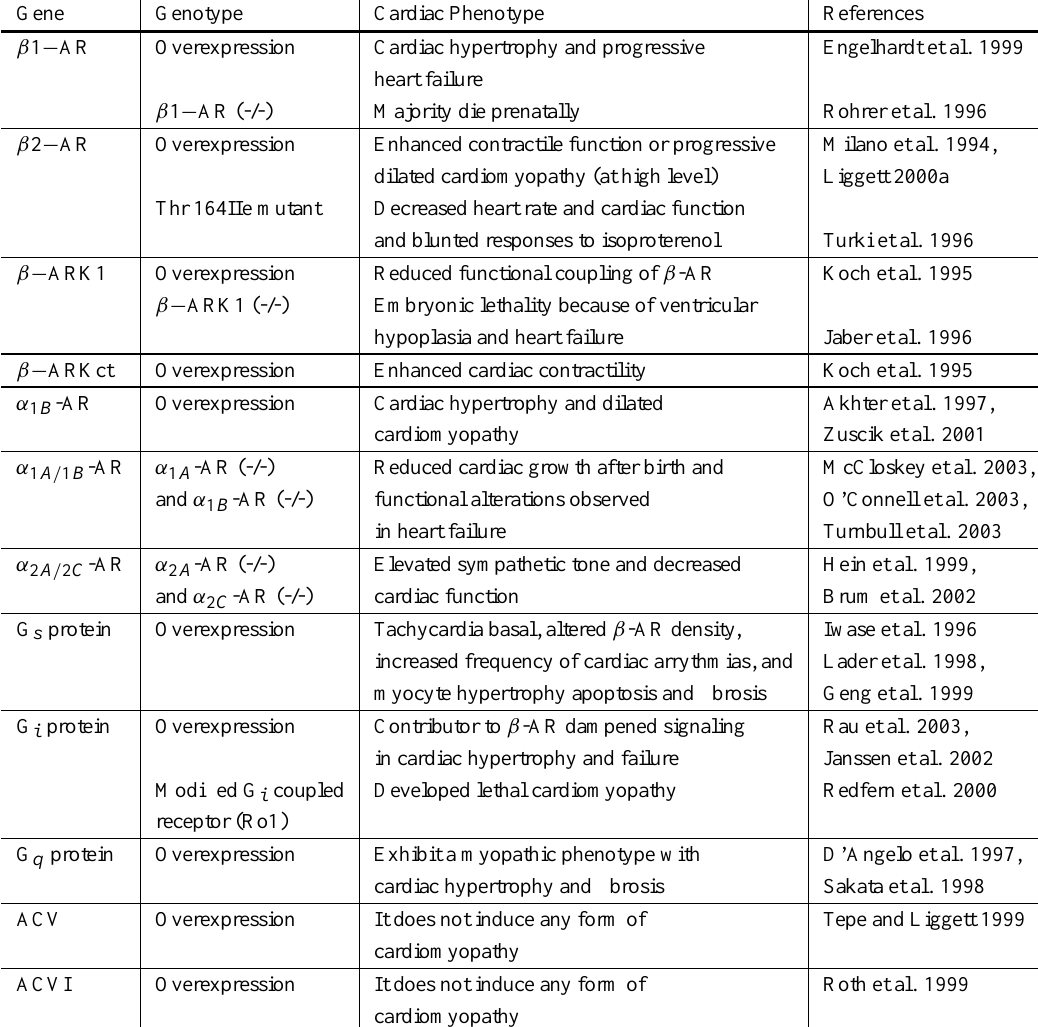
The genetically altered mouse models in an attempt to better understand the molecular mechanisms underlying the adrenergic receptor pathways in heart